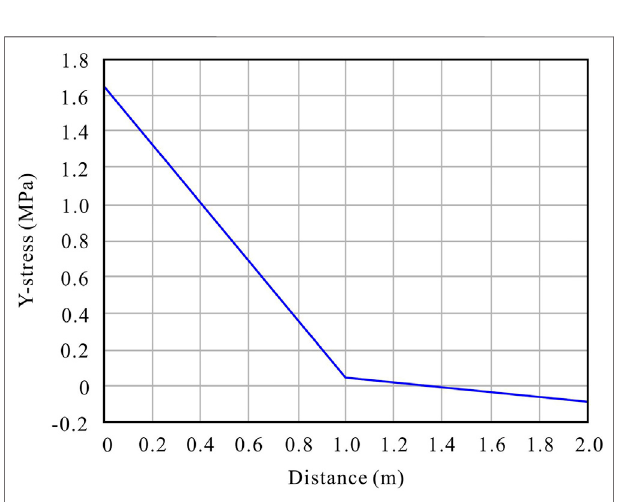
FIGURE6| Y -directiontensilestressattheleadingedgeofthecracktip.